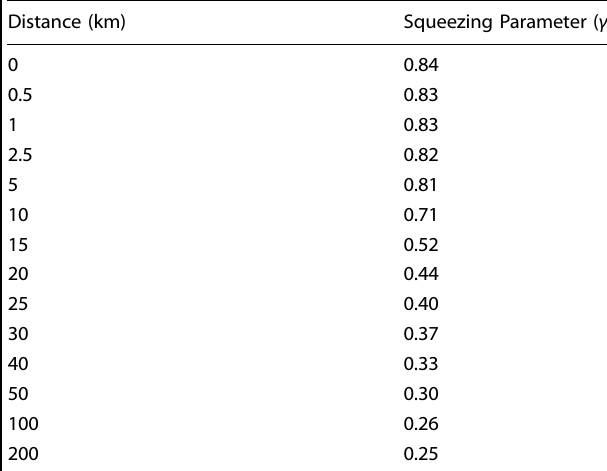
Table 4. The optimised squeezing parameters ( γ ) of the states shown in Eq. (1) with n max = 7 photons.